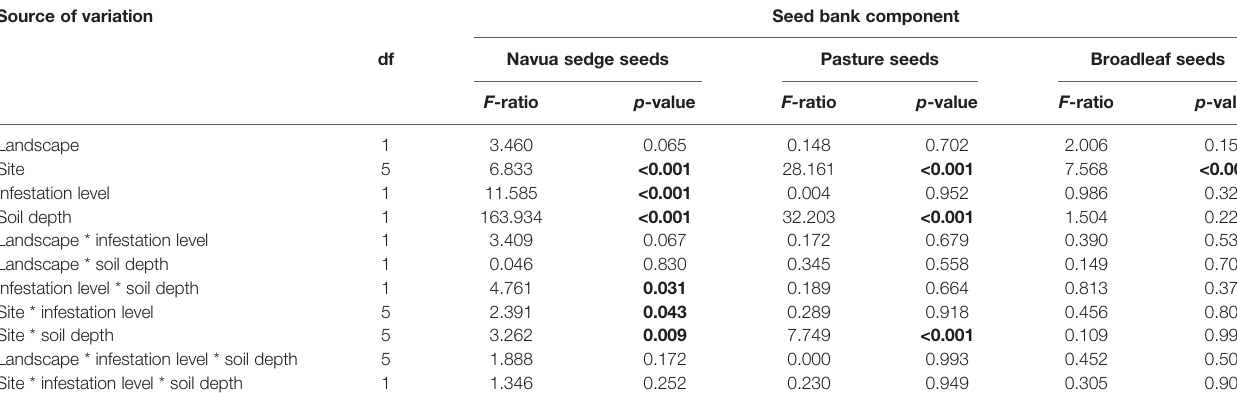
TABLE 2 | Summary of ANOVA for all main effects and their interaction investigated from the mixed models for Navua sedge, pasture and broadleaf seeds present in the soil. Source of variation